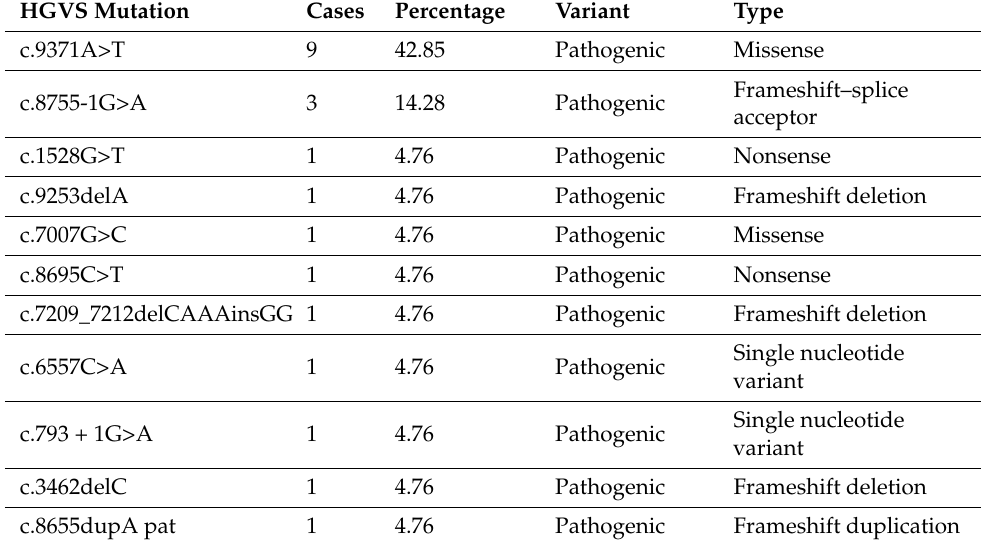
Table 3. Pathogenic BRCA 2 variants identified in the study group patients.